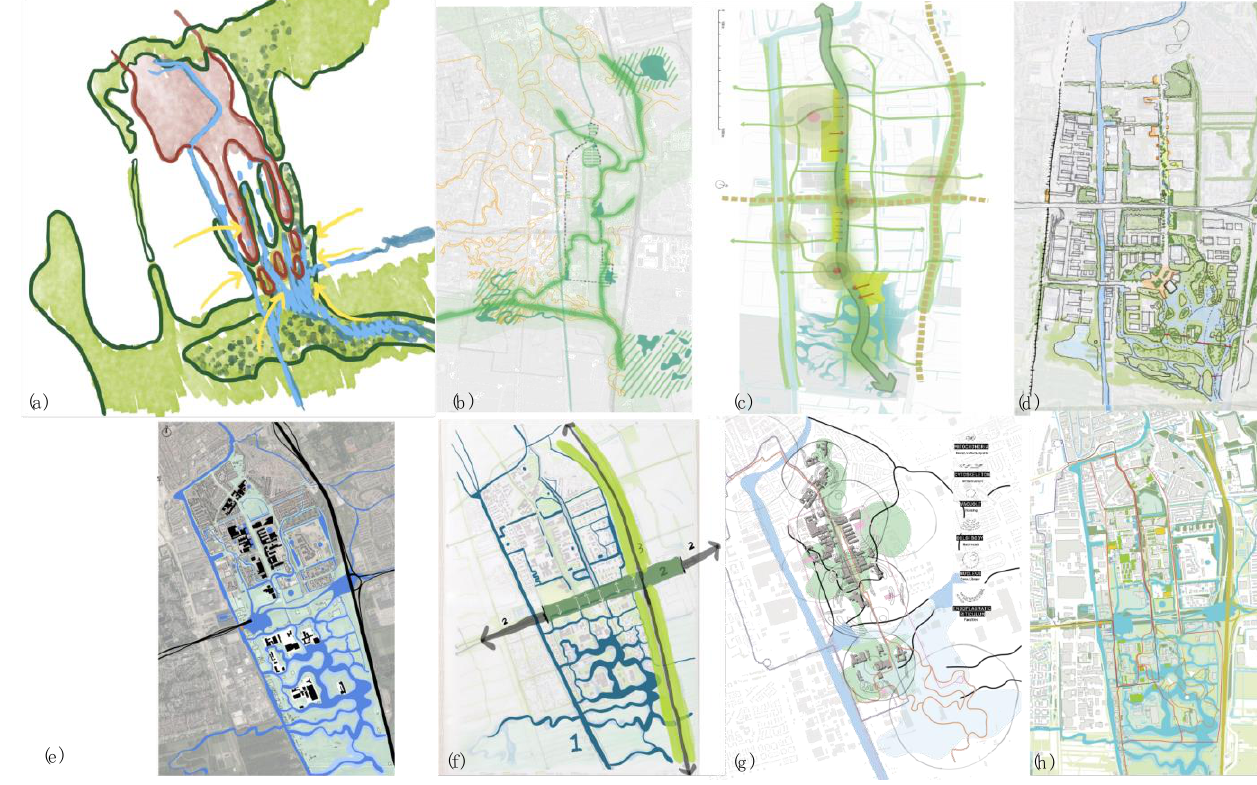
Figure 2. Emergence of the designed-redesigned master plan with ( a ) conceptual landscape, ( b ) pre- liminary green structure, ( c ) connected ecological spaces, ( d ) integrated green-urban landscape, ( e ) preliminary water system, ( f ) green-blue connectivity, ( g ) interconnected places, water, green and mobility, ( h ) integrated Master Plan.